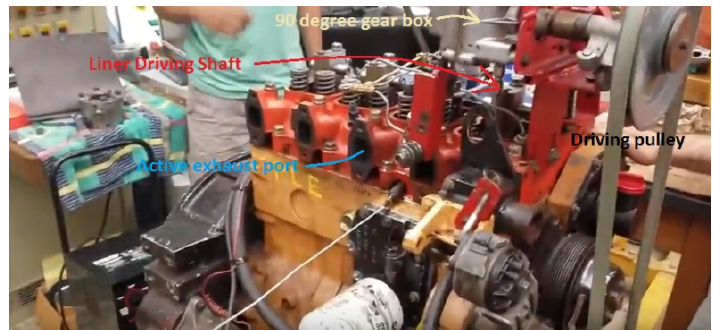
Figure 8. Overall layout of the prototype, seen here running. The 90-degree gearbox is the total transaxle of a small tractor, so it is much larger than it needs to be. The actual bevel gears used in there are approximately 3 inches in diameter. This gearbox was later replaced by a smaller and more efficient unit.